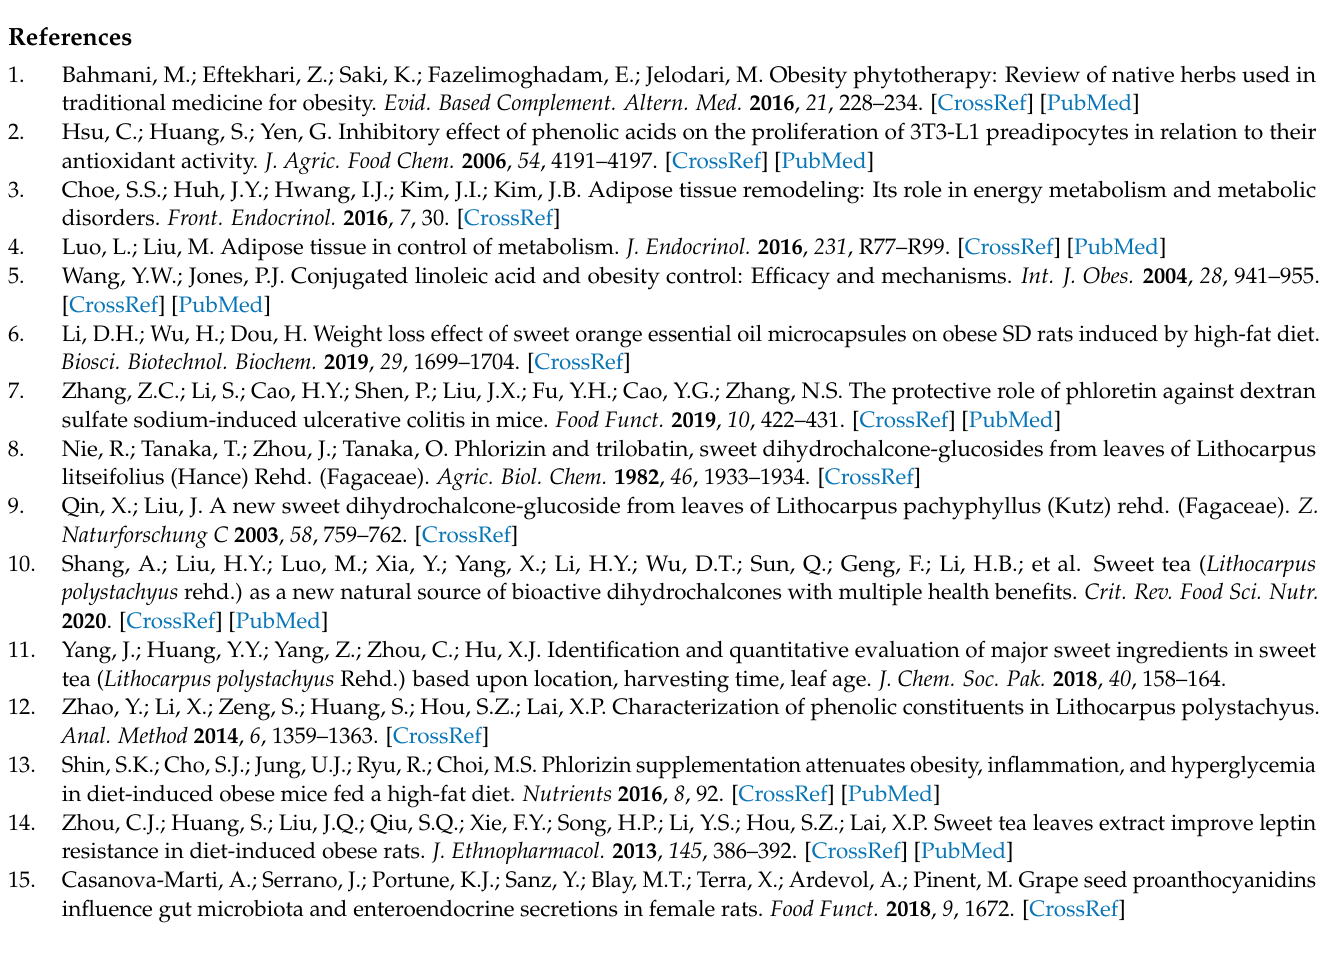
Table S1: The composition of chow